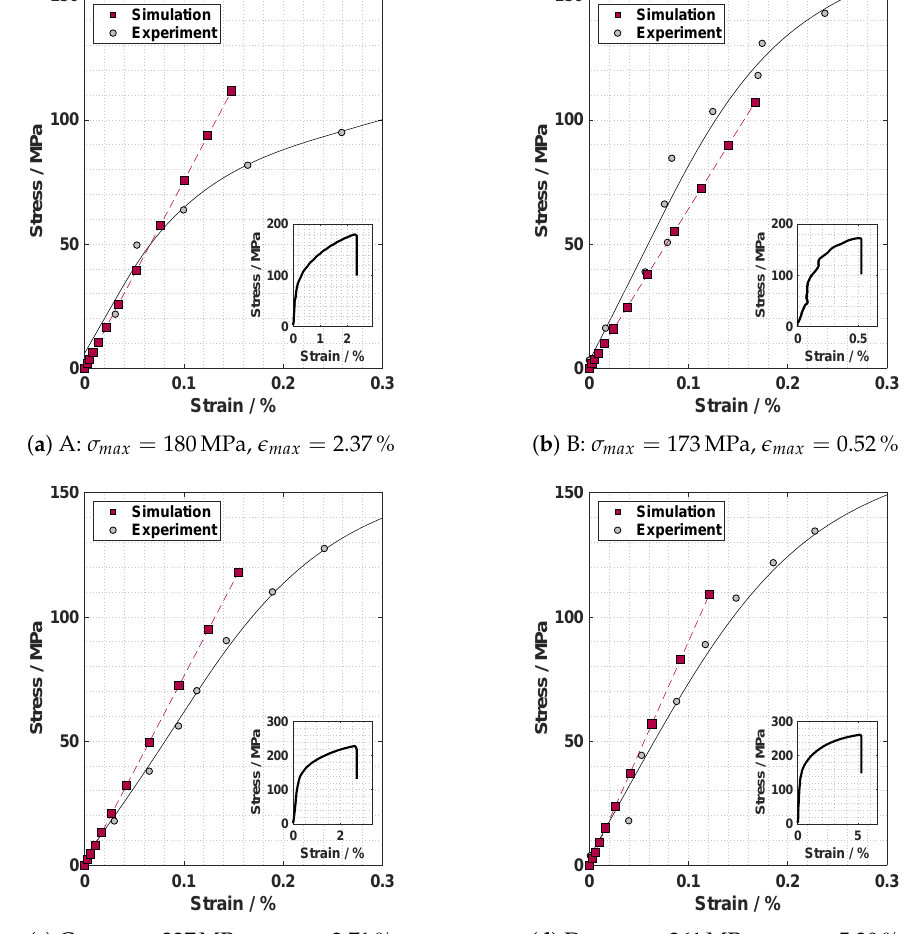
Figure 7. Comparison of the stress–strain curves for the welded test specimens from simulations and